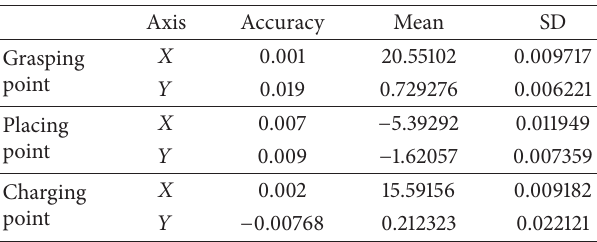
Table4:Accuracy,mean,andstandarddeviationofimportantrobot position in